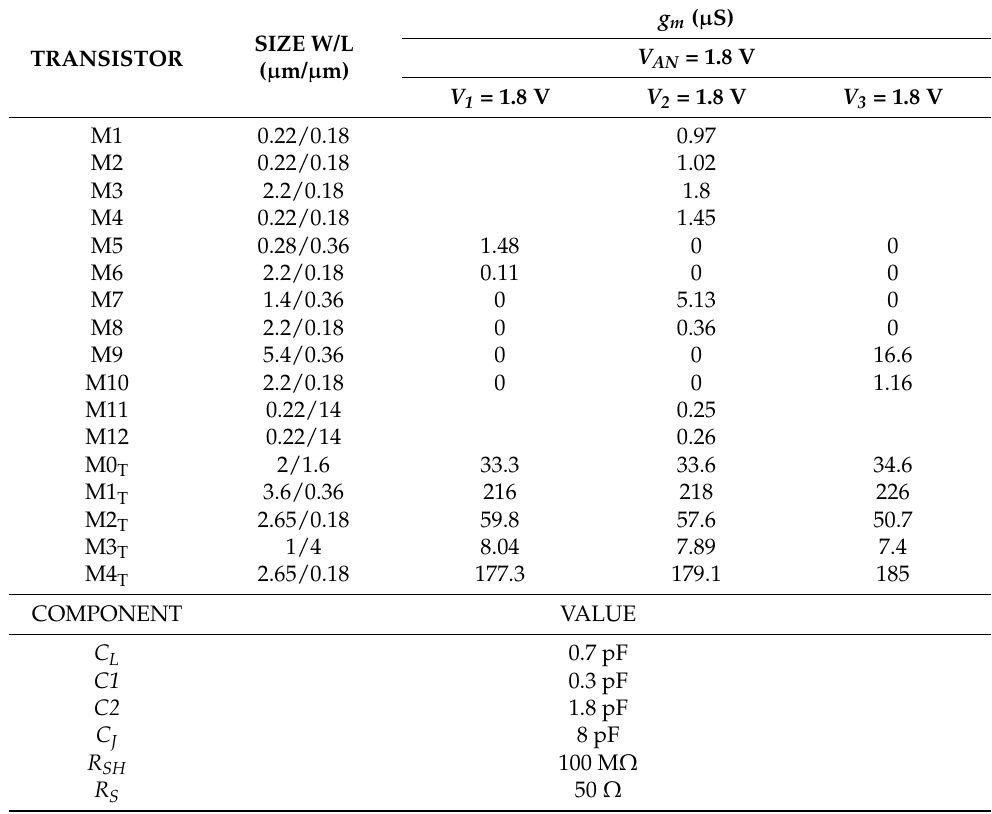
Table 1. Transistor sizes and values of the passive components of the optoelectronic sensing SoC.